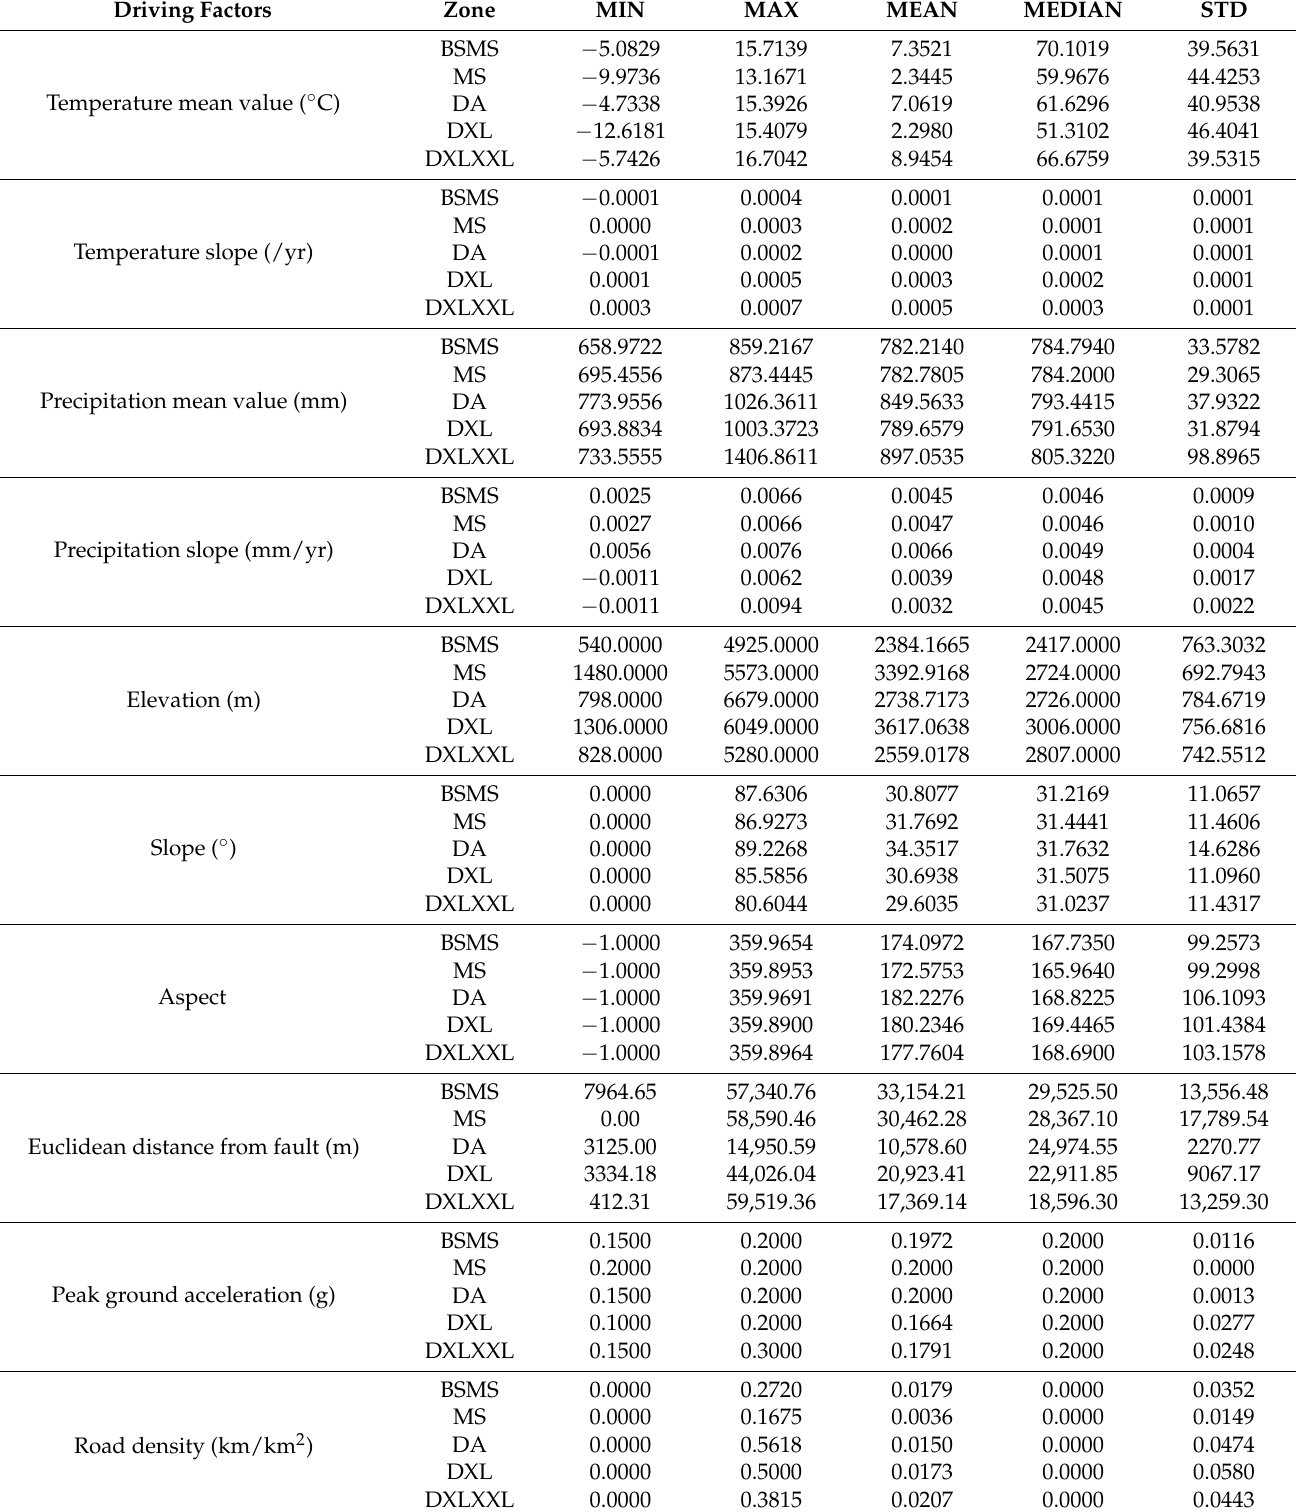
Table A1. Statistics of driving factors in different geomorphological